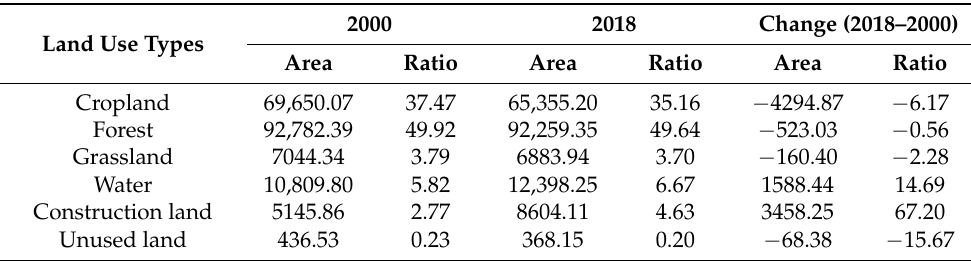
Table 1. Statistics of the areas (km 2 ) and ratios (%) of the land use types in Hubei Province in 2000 and 2018. Land Use Types Cropland Grassland 7044.34 Construction land 5145.86